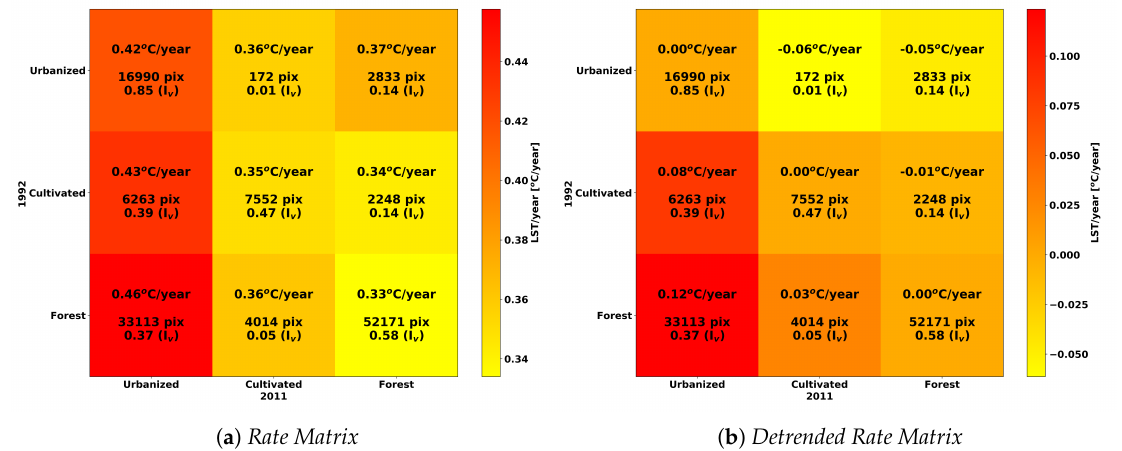
Figure 10. Atlanta MA warm period: Rate and Detrended Rate Matrices .